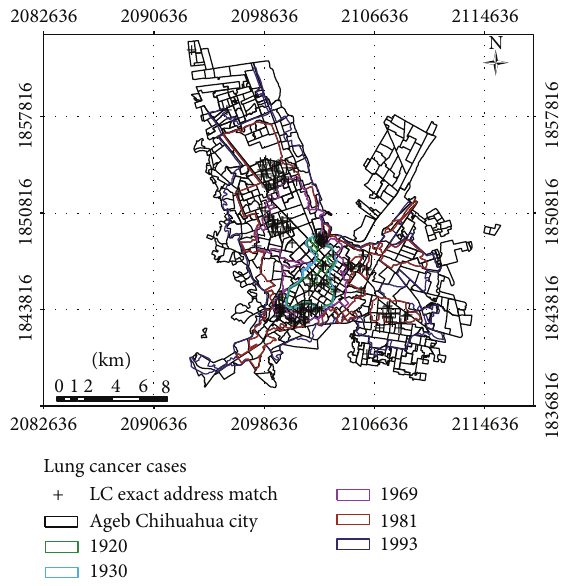
Figure 2: Historical growth of Chihuahua City versus LC deaths.